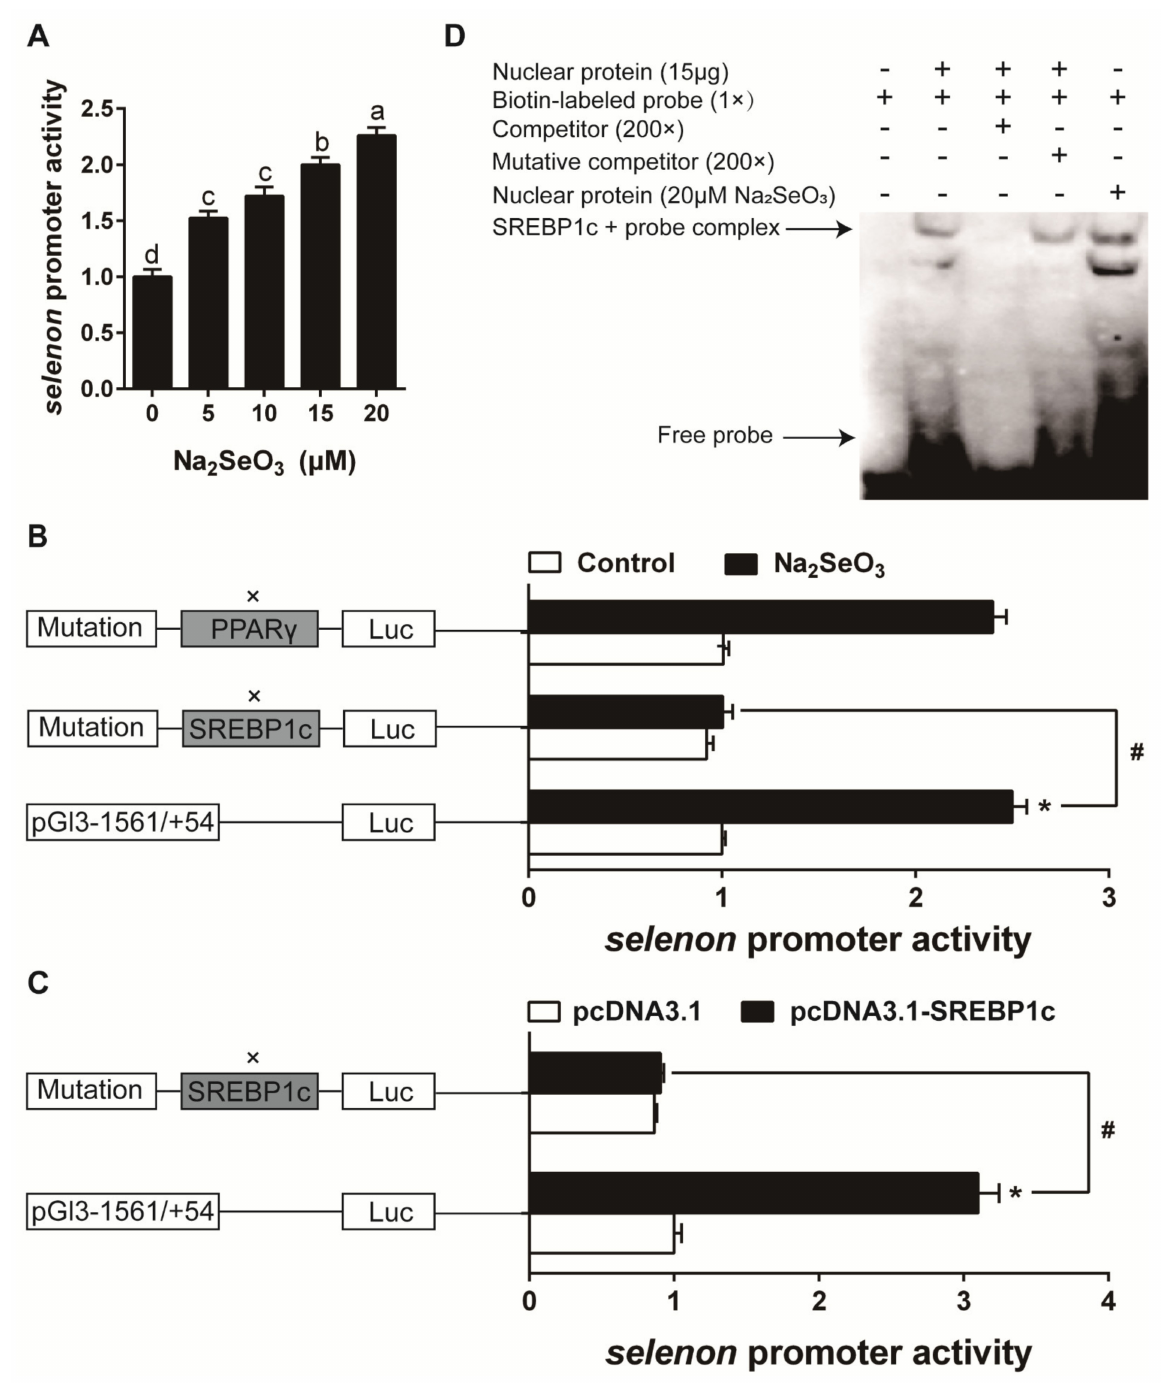
Figure 10. selenon promoter activity assays ( A – C ) and EMSA analysis ( D ) in the experiment 2. Values are means ± SEMs, n = 3. * Different from control, p < 0.05 (Student’s t test) and # Different from wild plasmid, p < 0.05 (Student’s t